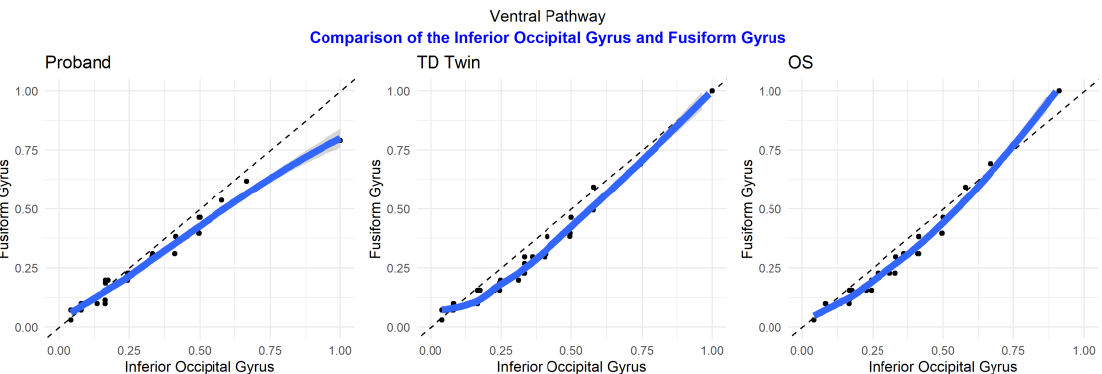
Figure 6. Q – Q plots of sibling comparisons of regions in the ventral pathway.